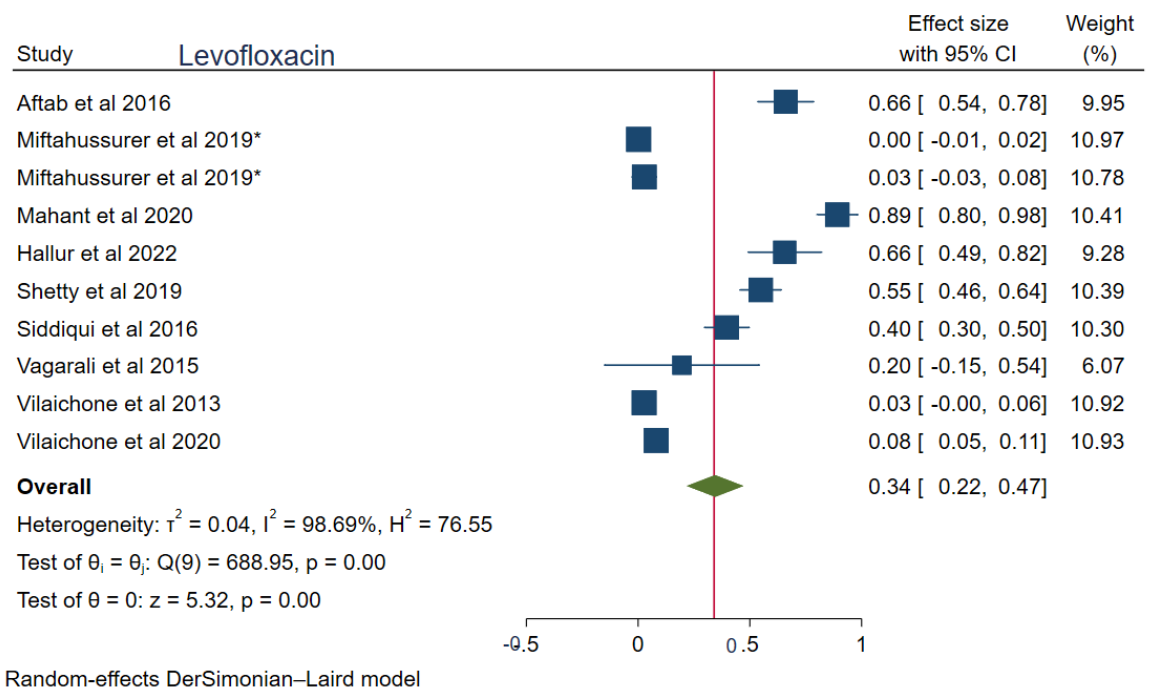
Figure 7. Forest Plot Showing Ciprofloxacin Resistance. (Reference studies: [21, 23, 27, 36, 37])